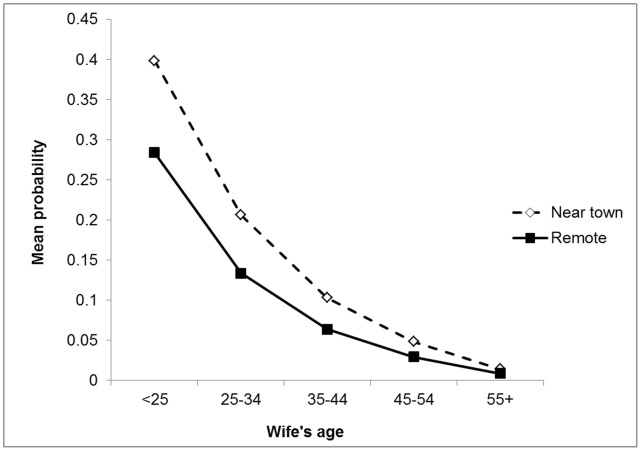
Probability of husband’s infidelity by town proximity and wife’s age.Control variables in table 1 set to sample means (sample min. and max. for wife’s age = 12 and 77, respectively).